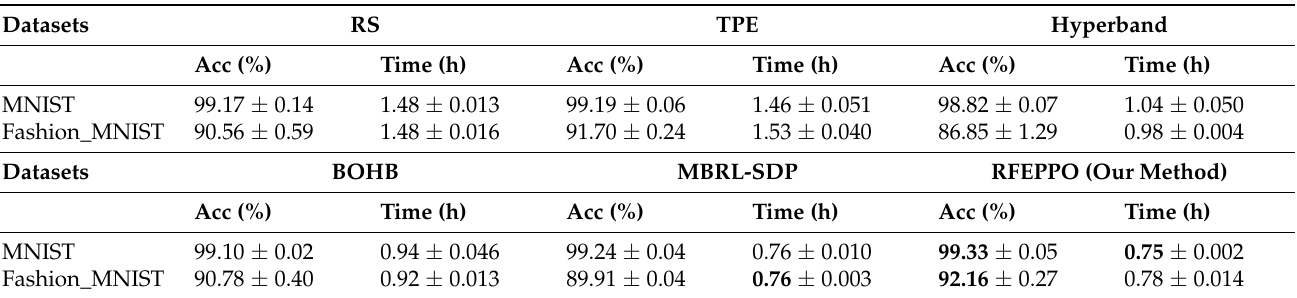
Table 5. The performance (mean ± std) of our method and other conventional algorithms on 2 image datasets.